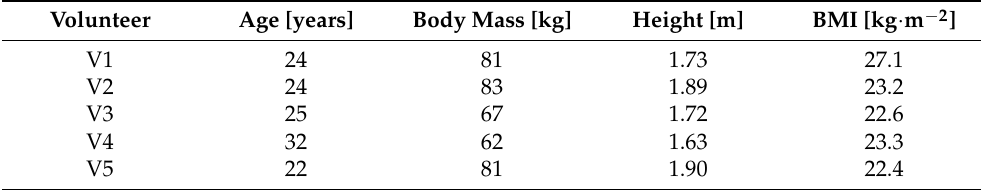
Table 1. Age, Body Mass, Height, and BMI (Body Mass Index) of the five volunteers. Volunteer